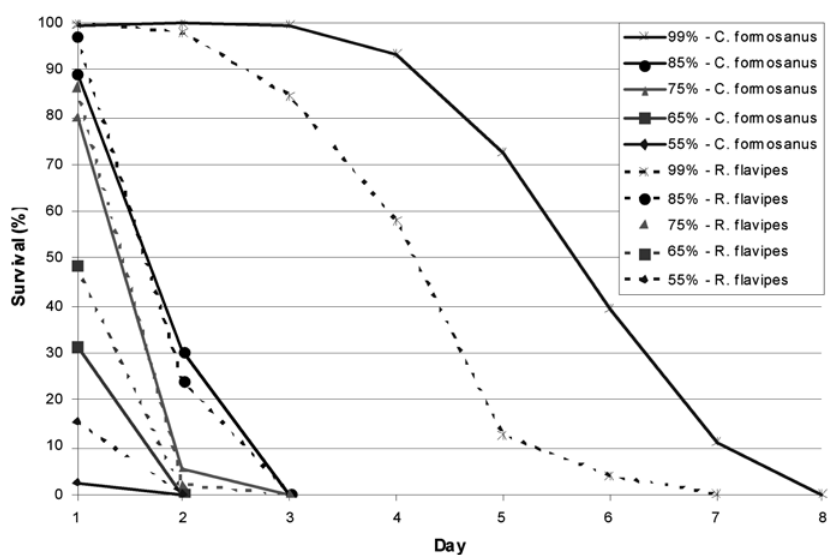
Fig. 5. Survival of small groups (18 workers + 2 soldiers) of C. formosanus and R. flavipes at 30 ° C and varying relative humidities.